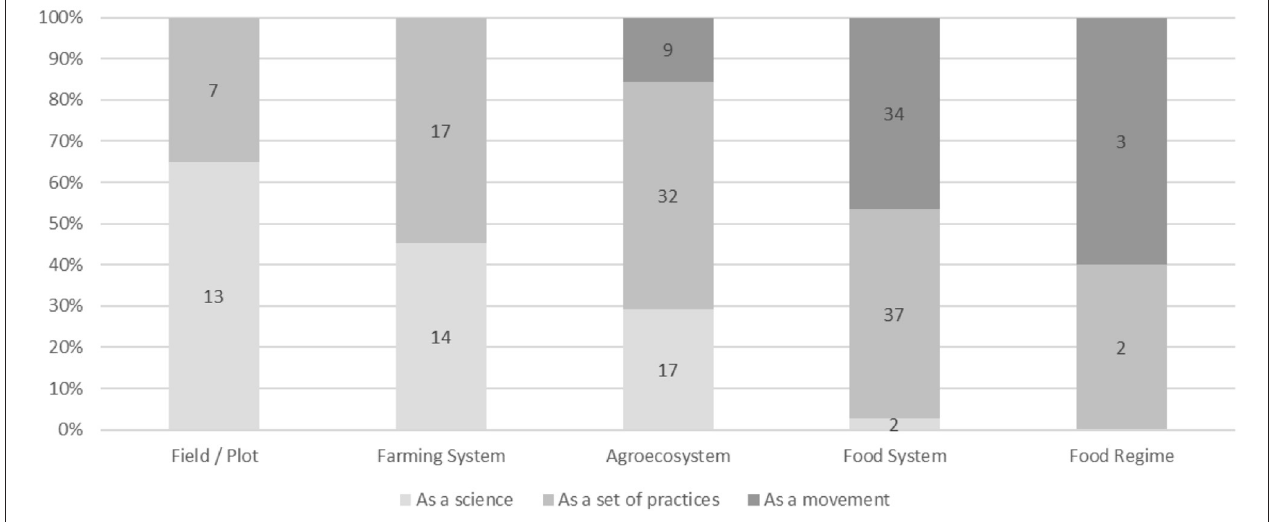
FIGURE 4 | Distribution of agroecological scale by the domain of agroecology considered in the